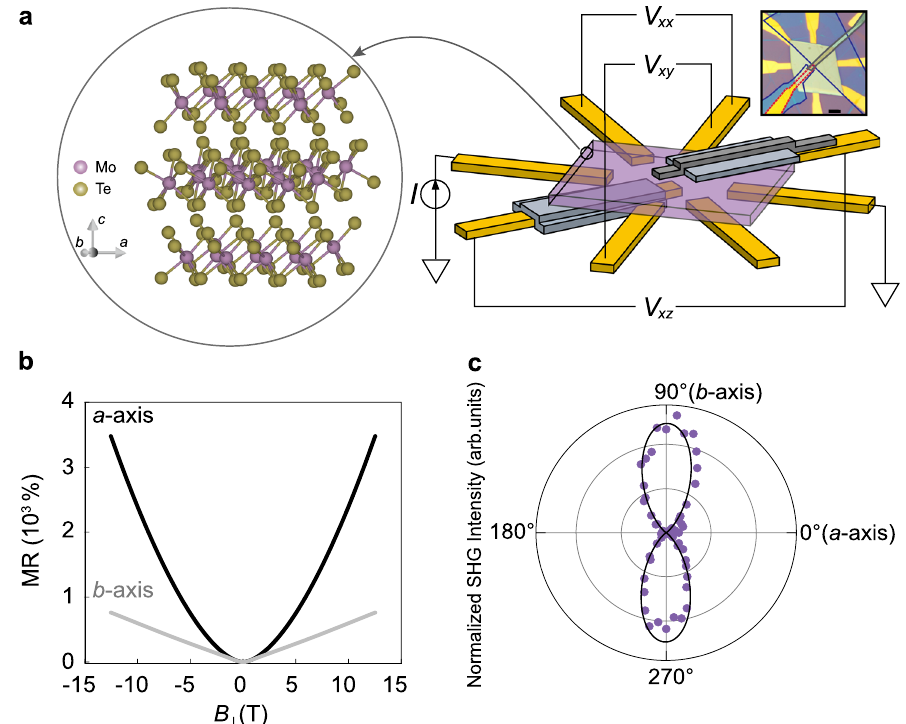
Fig. 1 NLAHE measurement schematic and sample characterization. a Main panel: crystal structure of MoTe 2 in the T d phase and device geometry. Purple, blue, and gray fl akes represent MoTe 2 , h-BN, and graphene, respectively. Inset shows optical image of 70-nm-thick device. h-BN blocking layers, graphene, and the bottom vertical contact are outlined in blue, gray, and red, respectively. Scale bar is 5 μ m. b Symmetrized magnetoresistance (MR) of 47-nm-thick device with current applied along the a and b crystal axes at 1.4 K. I k a ( I k b ) exhibits quadratic (linear) MR. c Angle-dependent second harmonic generation (SHG) intensity measured on the same sample. Minimum (maximum) intensity occurs along the a -axis ( b -axis).